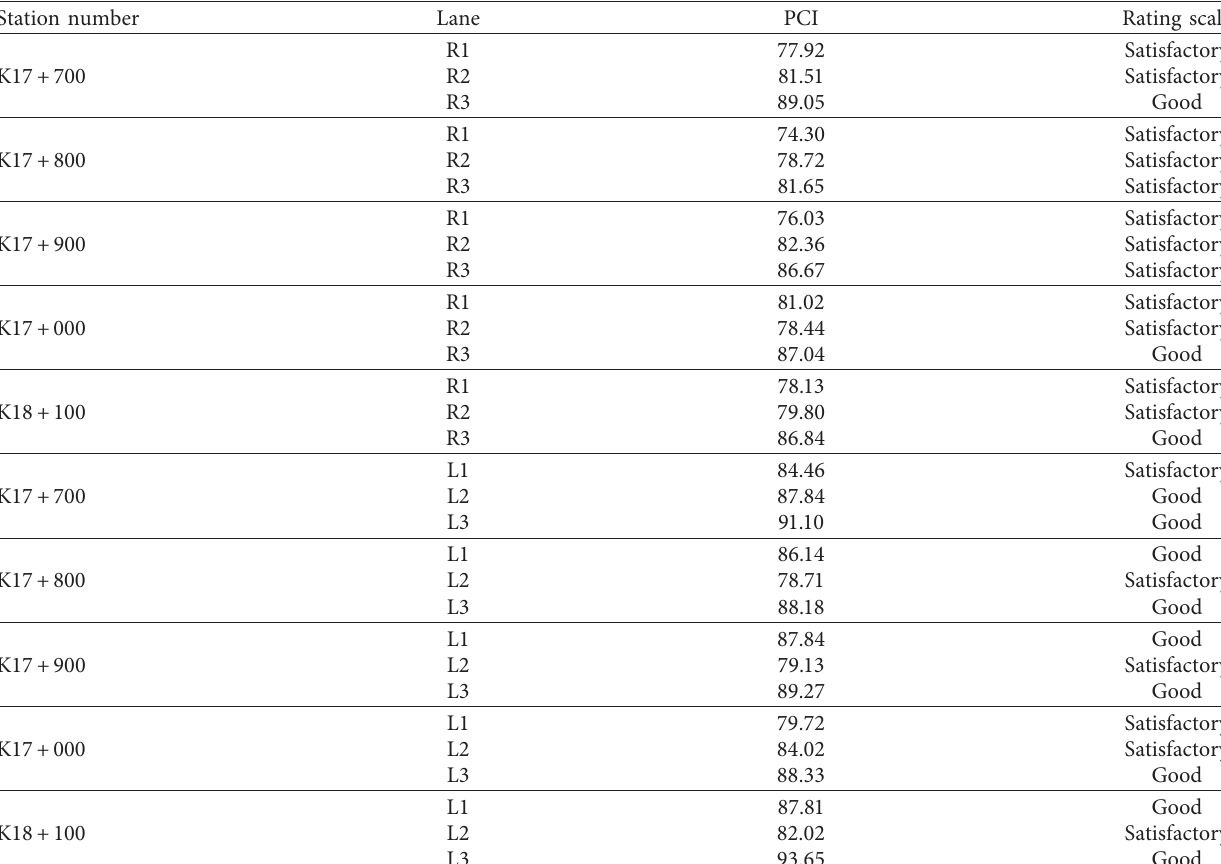
Figure 6: Pavement surface: (a) before WEB sand fog seal treatment; (b) after WEB sand fog seal treatment. Table 6: Pavement condition index (PCI) of the old